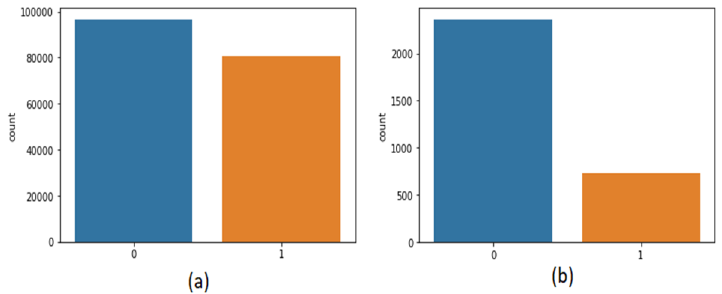
Figure 2. Frequency of positive or negative dataset of ( a ) first dataset ( b ) second dataset.